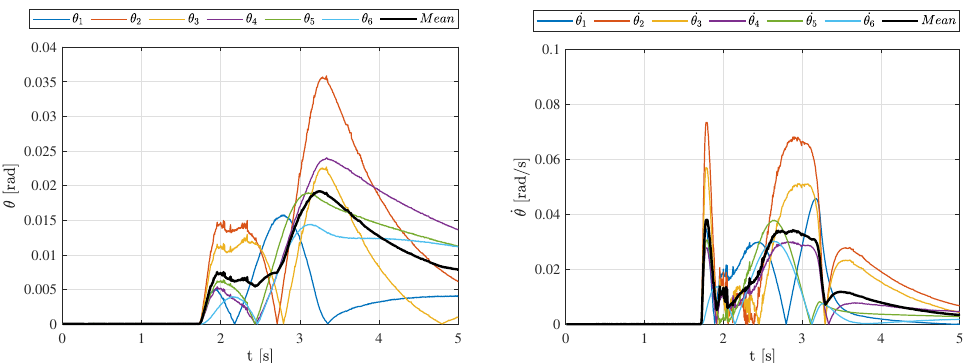
Figure 18. Test case 3, Mode I. The error between simulation and real system. Joint rotations ( left ) and joint speeds ( right